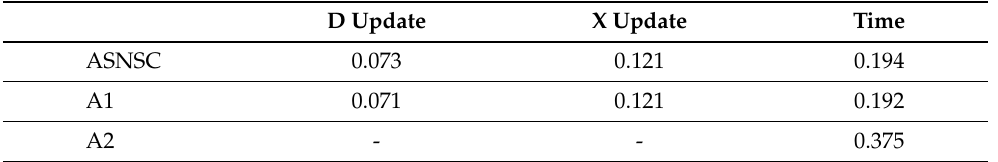
Table 2. Single iteration time (in seconds) for each algorithm for training a dictionary with 50 atoms on ETH